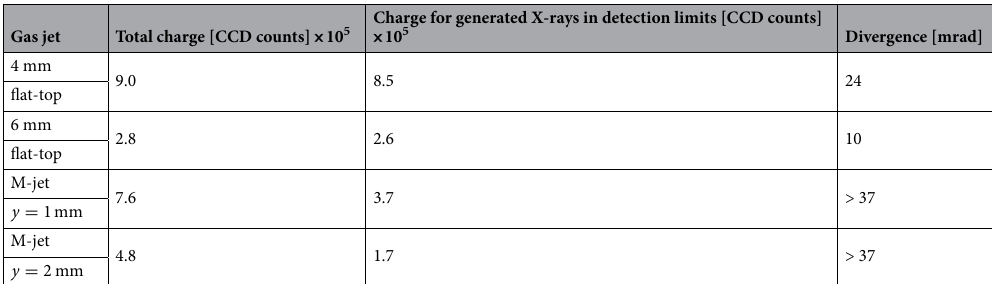
Table 2. Comparison of the generated electron beam spectra shown in Fig. 3. The third column is the charge integrated over an energy range, such that the lowest and highest generated critical photon energies lie in our detection range of 2.7–30